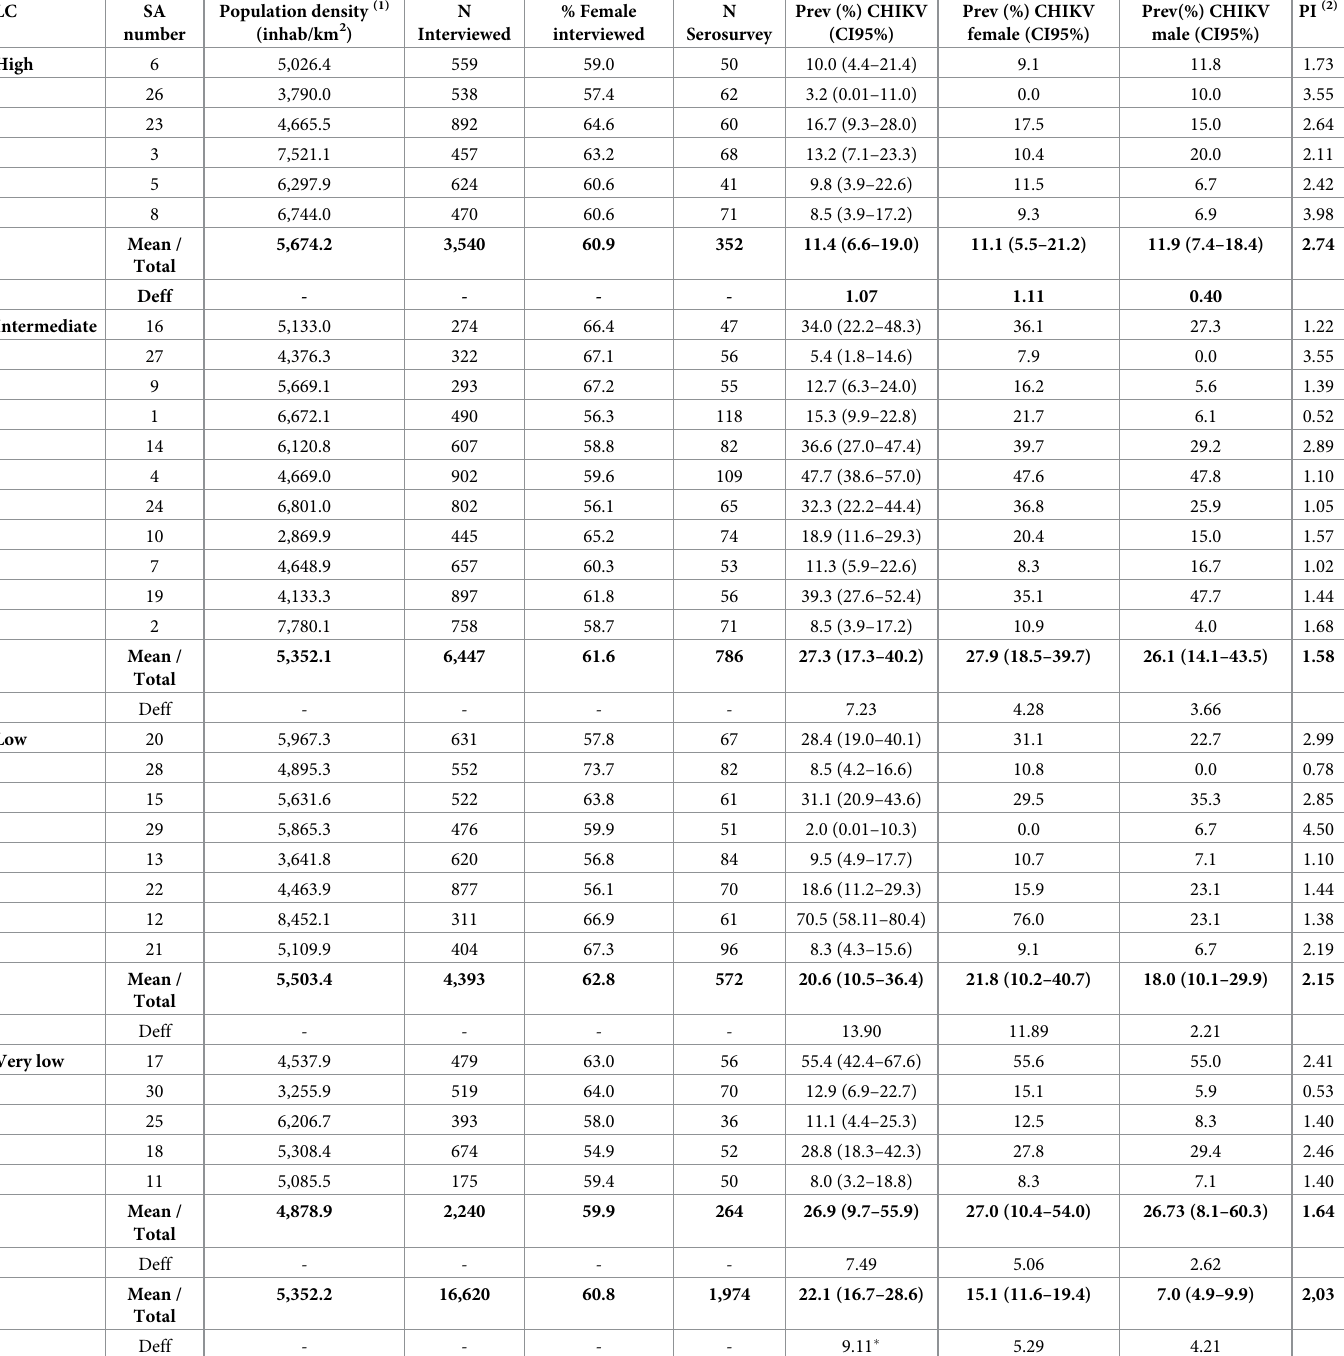
Table 2. Population density, number of interviewed people, number of serosurvey participants, seroprevalence of chikungunya virus (CHIKV) and Premise Index (PI) by Living Condition (LC) and Sentinel Area (SA). Feira de Santana–Bahia, April to September, 2017.